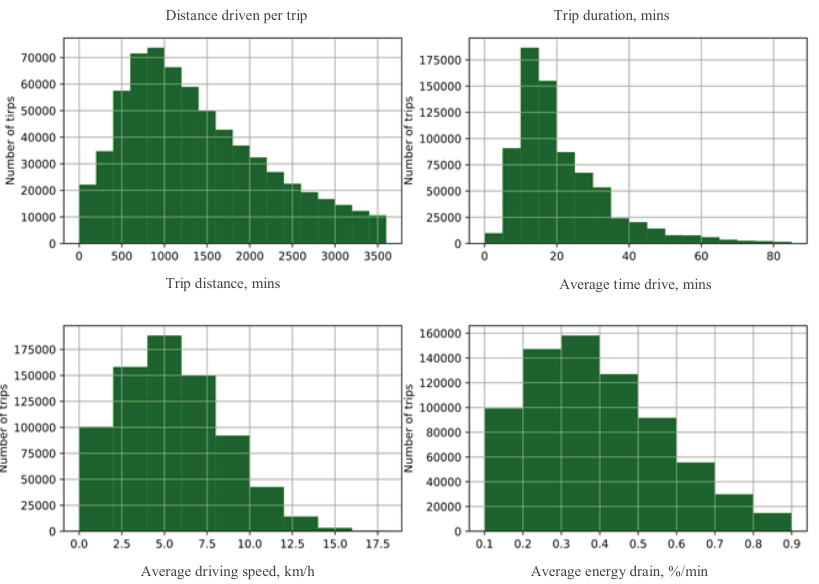
Fig. 4. Scooter trip descriptive statistics: trip distance, trip duration, trip speed and battery